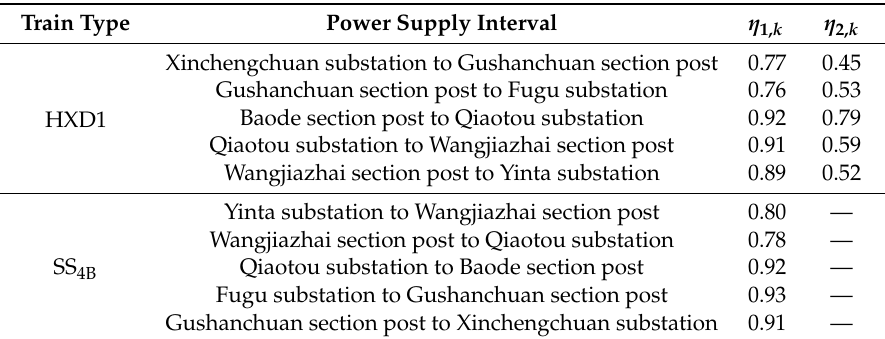
Table 3. Additional coefficients in some